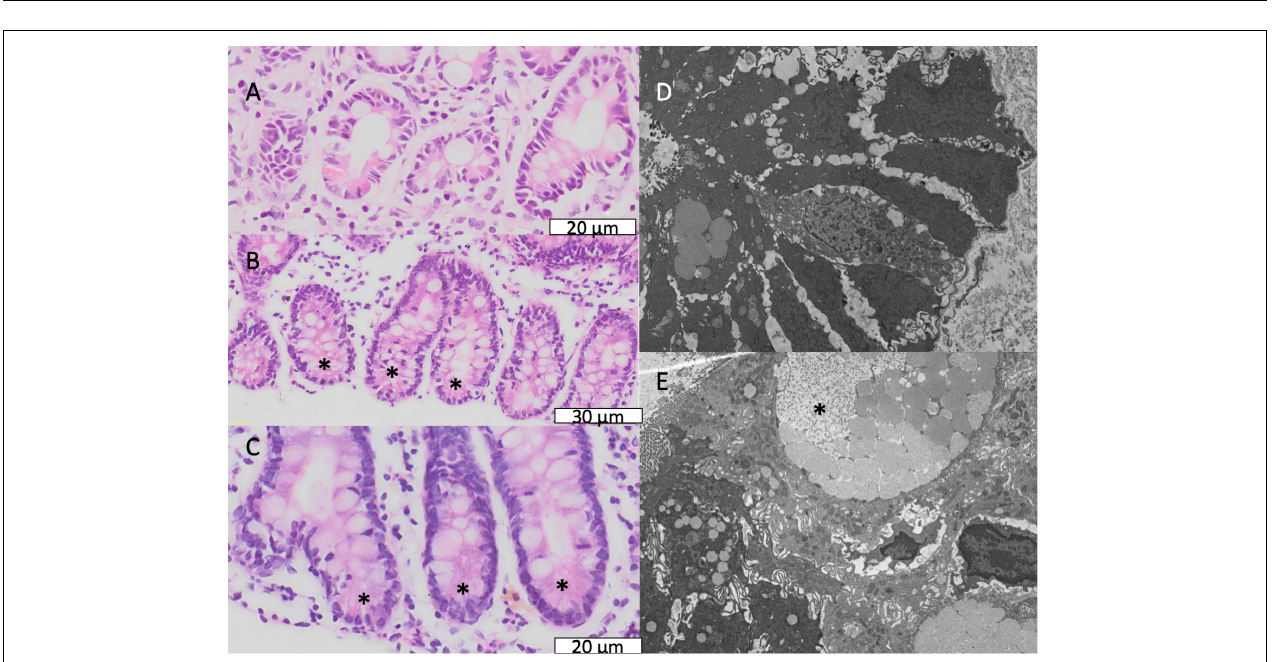
FIGURE 5 | Secretory cell abnormalities in environmental enteropathy. (A–C) Paneth cell depletion; the expected location of Paneth cells is shown, normally recognisable by brightly eosinophilic granules. (D,E) Electron micrographs of goblet cells with depleted granules.